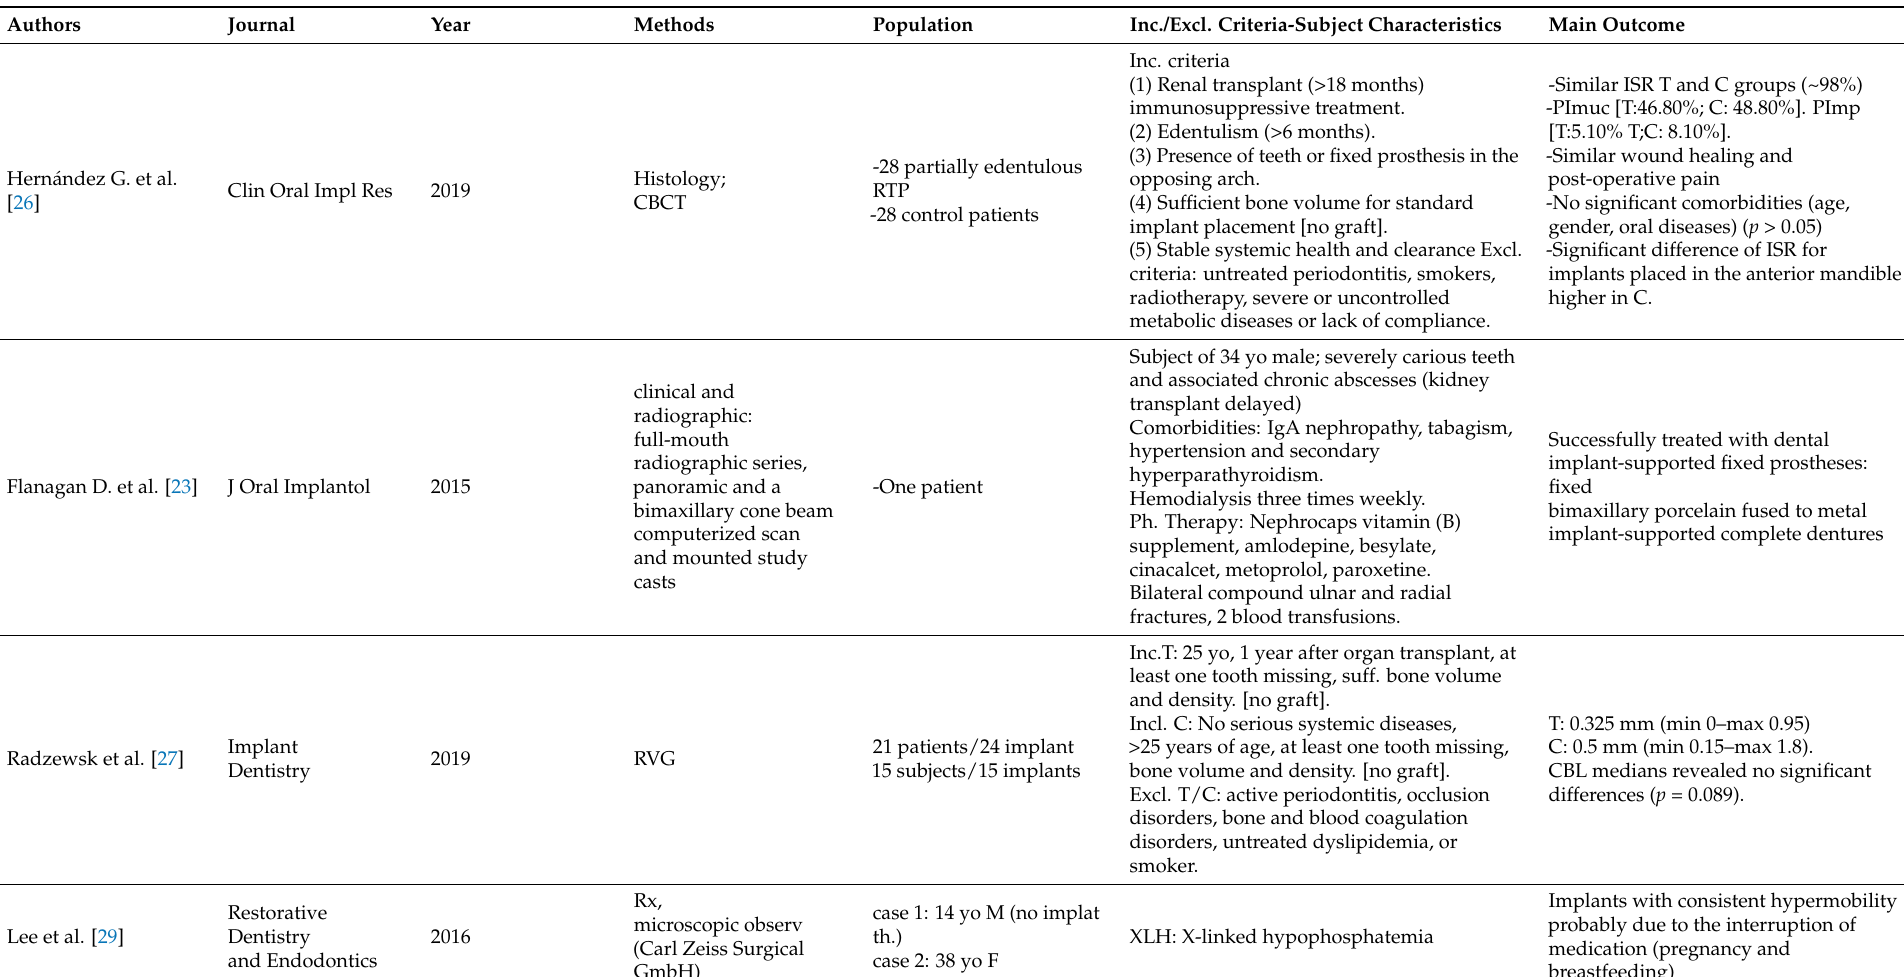
Table 3. Descriptive summary of included studies [Auth, Journal, Year, Methods, Population, Inc/excl criteria, Main